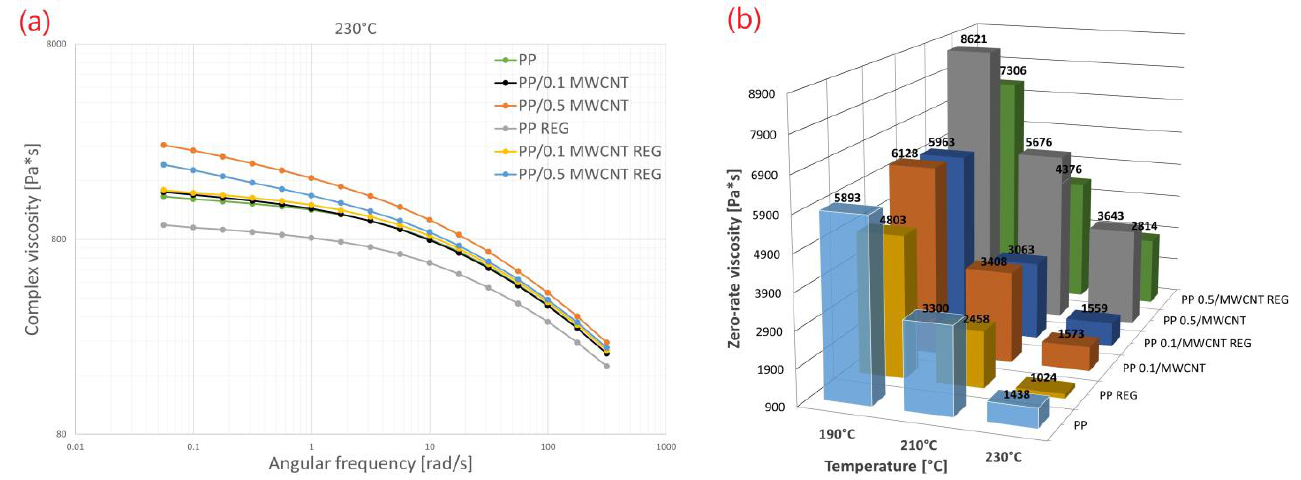
Figure 5. ( a ) Complex viscosity curves (230 ◦ C); ( b ) zero-shear-rate viscosity in the function of the temperature of